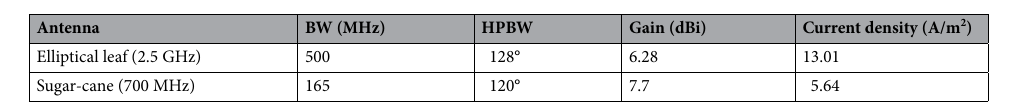
Table 4. Comparison of the directional monopole antennas bioinspired elliptical leaf and sugar-cane 4 .